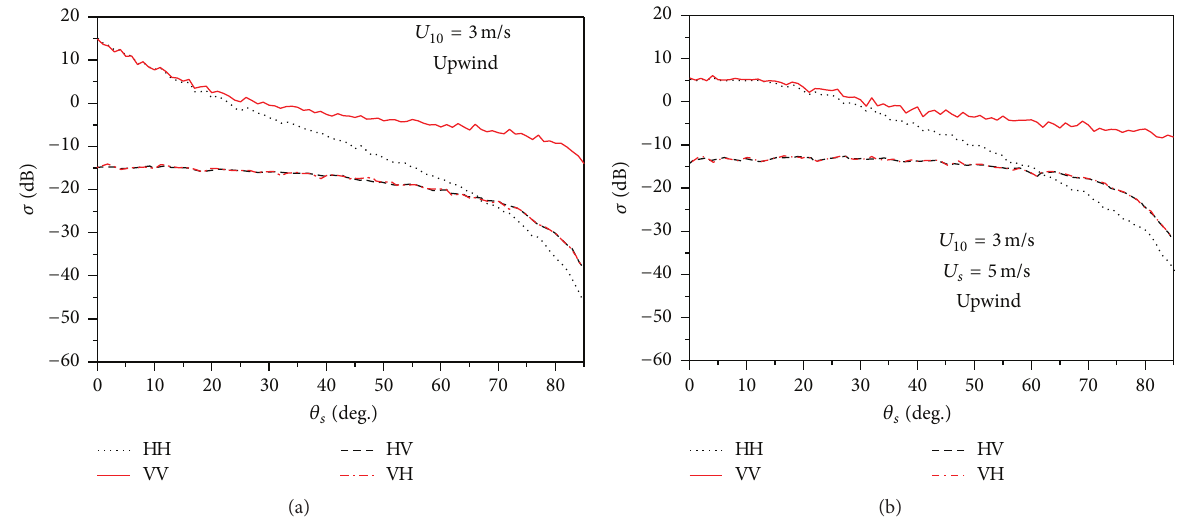
Figure 5: Comparison between copolarized and cross-polarized backscattering coefficient with wind speed 𝑈 10 = 3 m/s. (a) Sea surface alone and (b) sea surface with wake at ship speed 𝑈 𝑠 = 5 m/s.